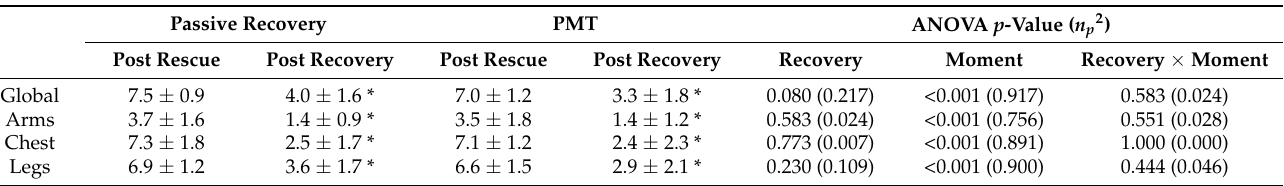
Table 1. Results of the RPE scale (mean ± SD).